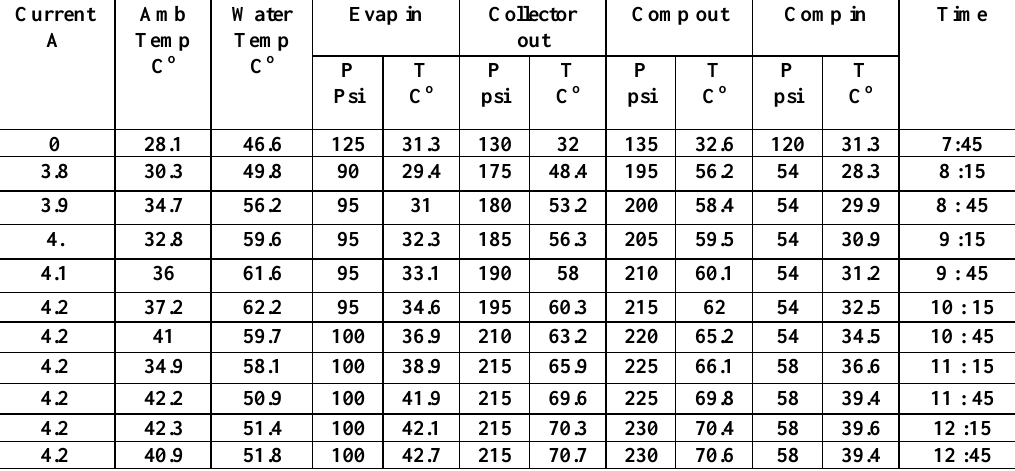
Fig. 9 P-h chart with water 27/9 Table 2: Hybrid solar collector with water